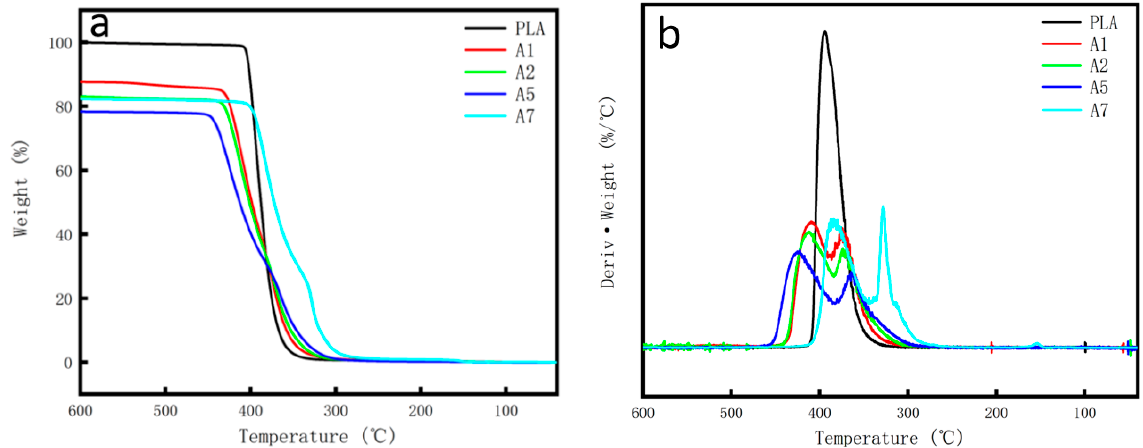
Figure 6. Thermogravimetric analysis of different PLA/PBS composites: ( a ) TG curves and ( b ) DTG curves. Table 2. Thermal decomposition temperature of PLA and composites.